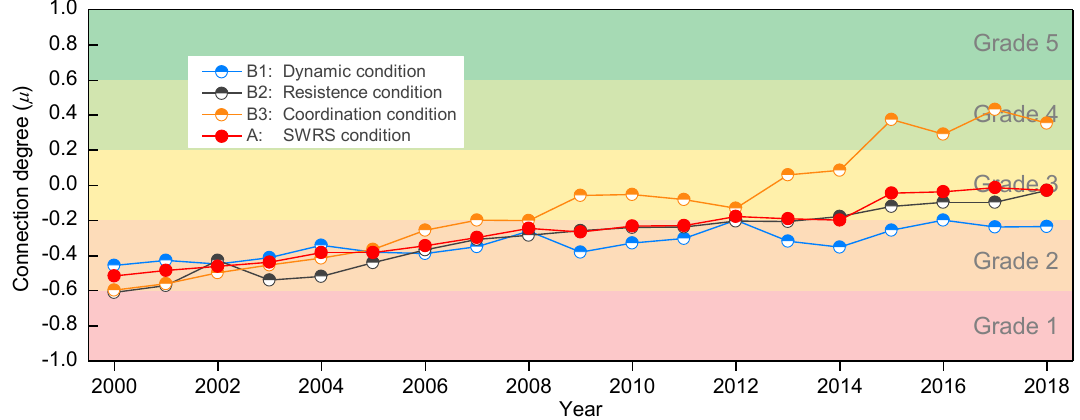
Figure 5. Dynamics of the connection degree of the SWRS condition and its components.